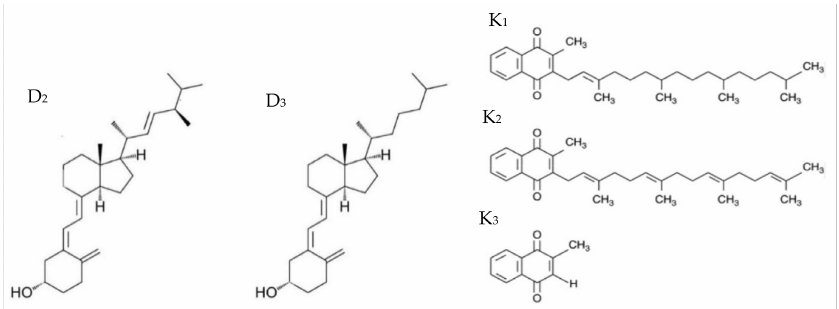
Figure 1. Structural formulas of vitamins D 2 , D 3 , K 1 , K 2 and K 3